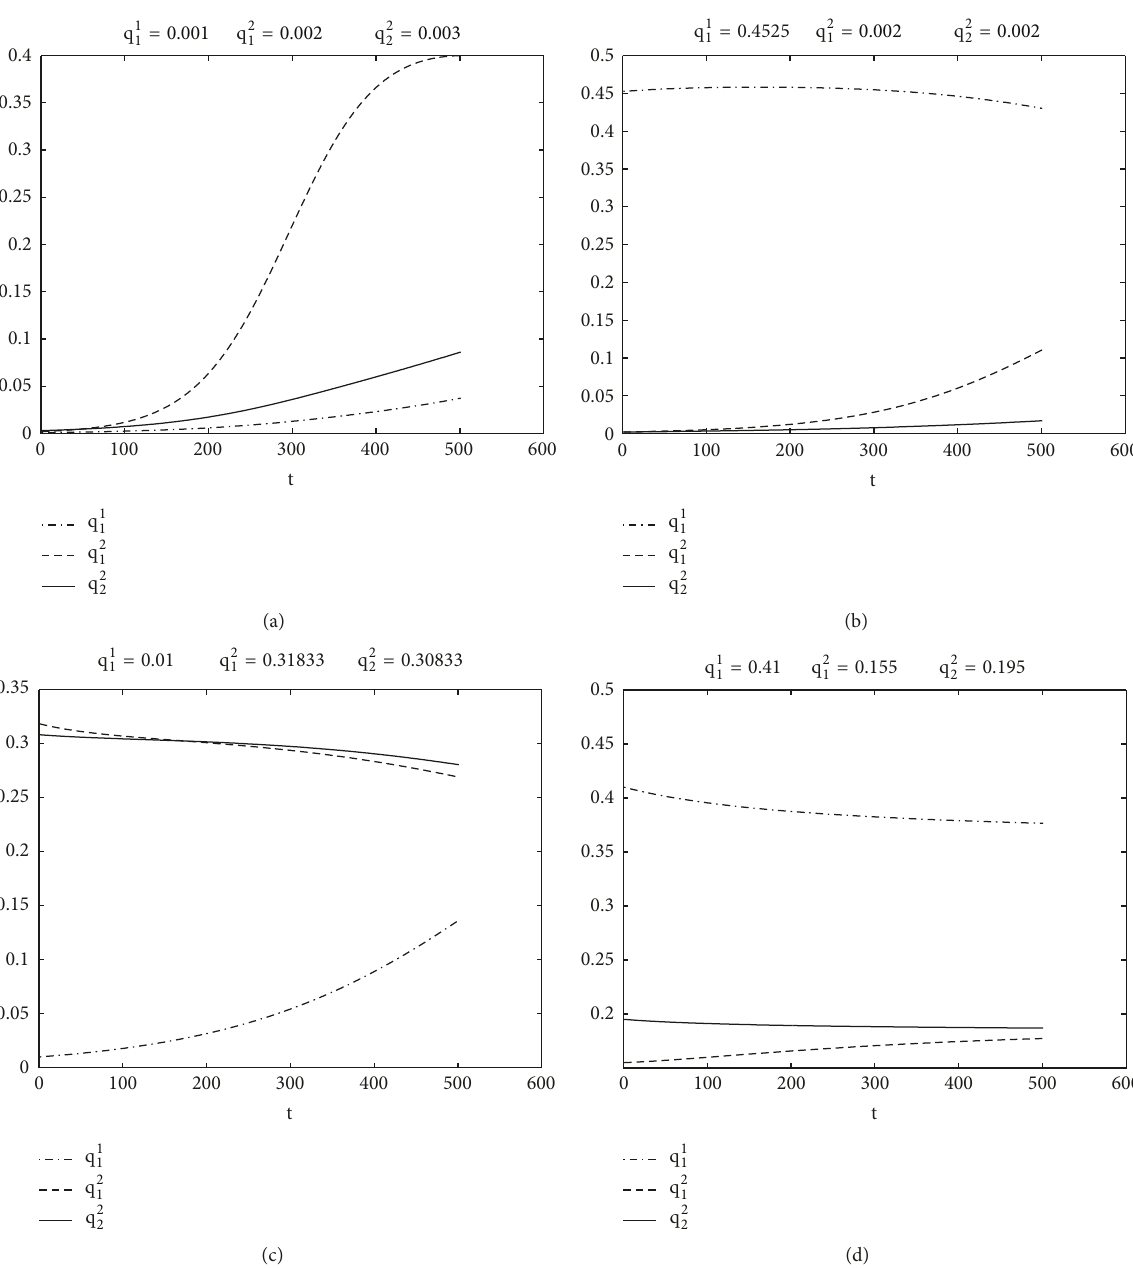
Figure 2: Subgraphs (a), (b), and (c) show the solutions of (15) with an initial value near 𝐸 0 , 𝐸 2 , and 𝐸 6 , respectively. Subgraph (d) displays the solution of (15) with an initial value near 𝐸 7 . It can be observed that 𝐸 7 is stable and 𝐸 𝑖 is unstable for 𝑖 = 0, 2, 6 . Subgraph titles clarify the initial points of system (15). The parameters are set as follows: 𝑐 = 0.075, 𝛼 1 1 = 0.01,𝛼 2 1 = 0.02 , and 𝛼 2 2 = 0.01